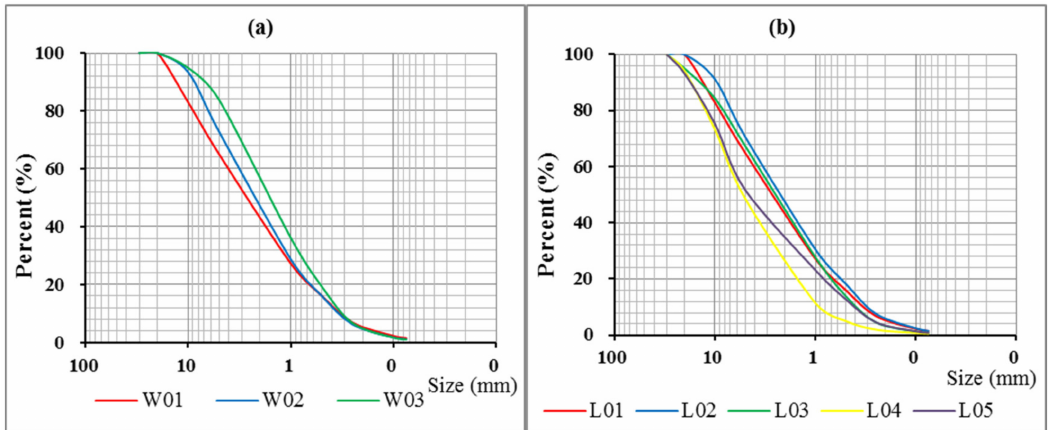
Figure 4. Grain size analysis curves. ( a ) shows the soil size at di ff erent depths, and ( b ) shows the soil size at 15 cm under di ff erent vegetation types).